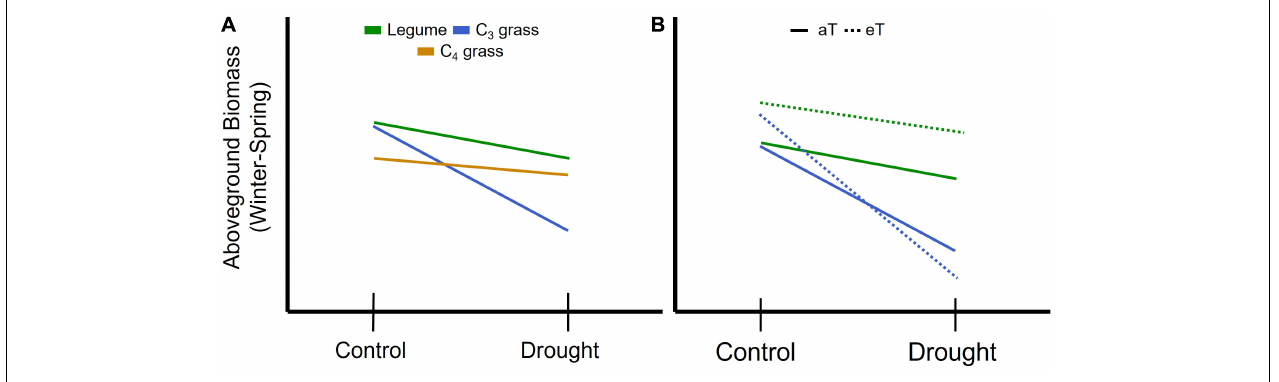
FIGURE 1 | Schematic representation of expected changes in aboveground plant biomass during winter and spring associated with concurrent drought for (A) plant functional groups including legumes and grasses relying on either the C 3 or C 4 photosynthetic pathways. Legumes are predicted to be less affected by drought (shallower slope) due to their higher nutrient and water use efficiency compared with C 3 grasses, while C 3 grasses are predicted to be most affected by drought due to their comparatively lower water use efficiency. C 4 grasses are predicted to have lower biomass due to low temperature constraints on growth but lower drought sensitivity than C 3 species due to greater water use efficiency. (B) For legumes (green) and C 3 grasses (blue) winter and spring warming (eT) is predicted to increase productivity under the control precipitation treatment relative to ambient temperature (aT; solid line); potential interactions between drought and warming can include an amplifying effect resulting in increased loss of biomass (C 3 grass) or a stabilizing effect where warming offsets the impact of drought on biomass (legume).